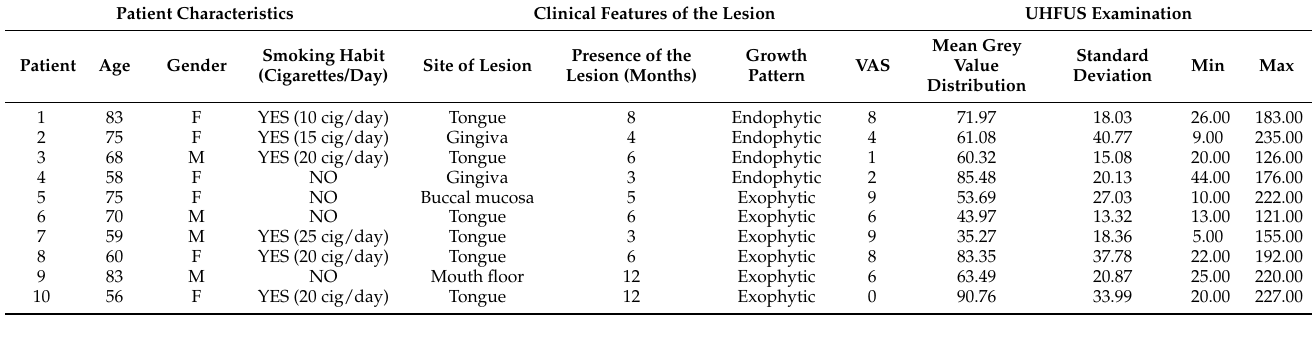
Table 1. Sample characteristics. Acronyms: UHFUS = ultra-high frequency ultrasound; VAS = visual analogue scale.